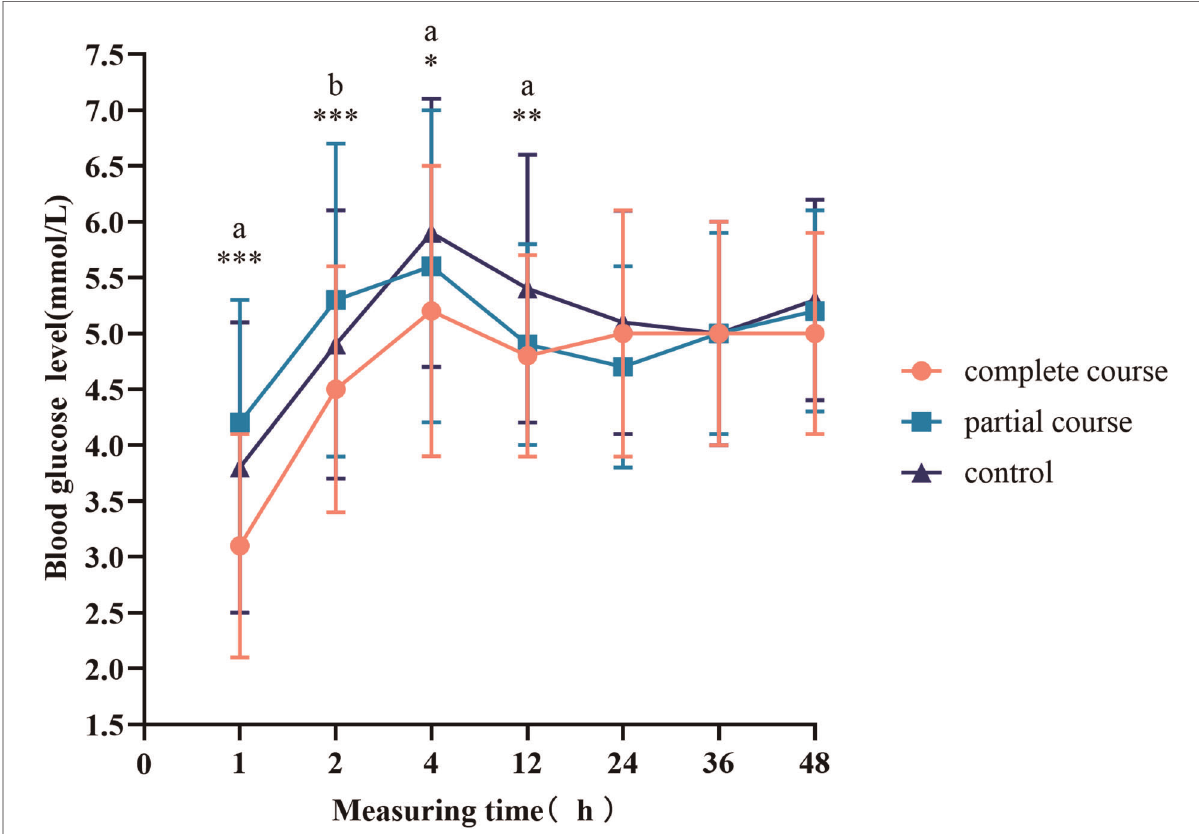
FIGURE 2 Blood glucose levels at different time points. The curves represent the mean and standard deviation of blood glucose at a speci fi c time point. Comparison of blood glucose levels among all groups, * p <0.05, ** p <0.01, *** p <0.001; a p <0.0167 for the comparison of the complete course or partial course group with the control group. b p <0.0167 for the comparison of the complete course group with the partial group.